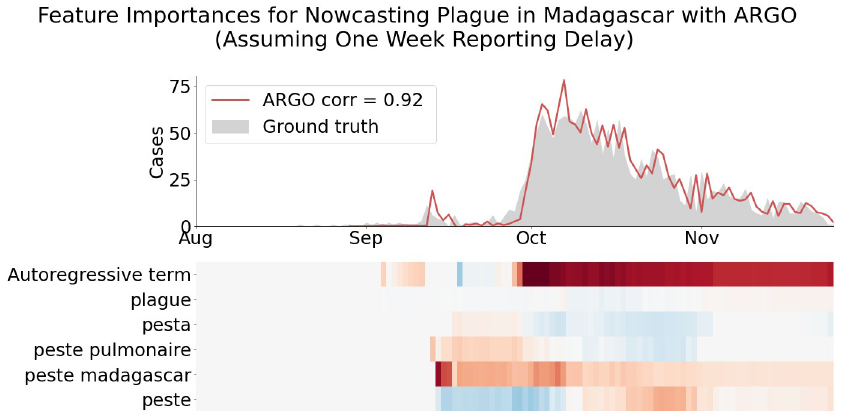
Fig 3. Evaluating feature importances (coefficients in linear regression) in ARGO for nowcasting plague in Madagascar assuming a reporting delay of one week. In the heatmap, darkest reds correspond to largest positive coefficients and darkest blues correspond to largest negative coefficients; grey indicates a coefficient of zero. Since the model is trained dynamically, feature importances shift from week to week. Note that the autoregressive term is extremely important, but information from Google search trends is also used, particularly early on in the